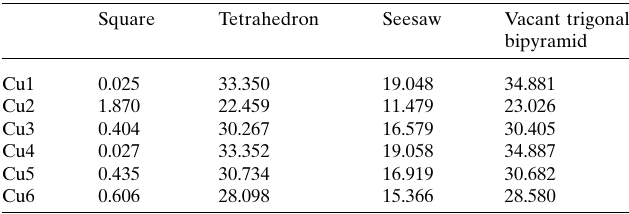
Table 2 Continuous shape measurement (CShM) values ( SHAPE 2.1 ; Llunell et al. , 2013) for the four-coordinate copper(II) ions. Square